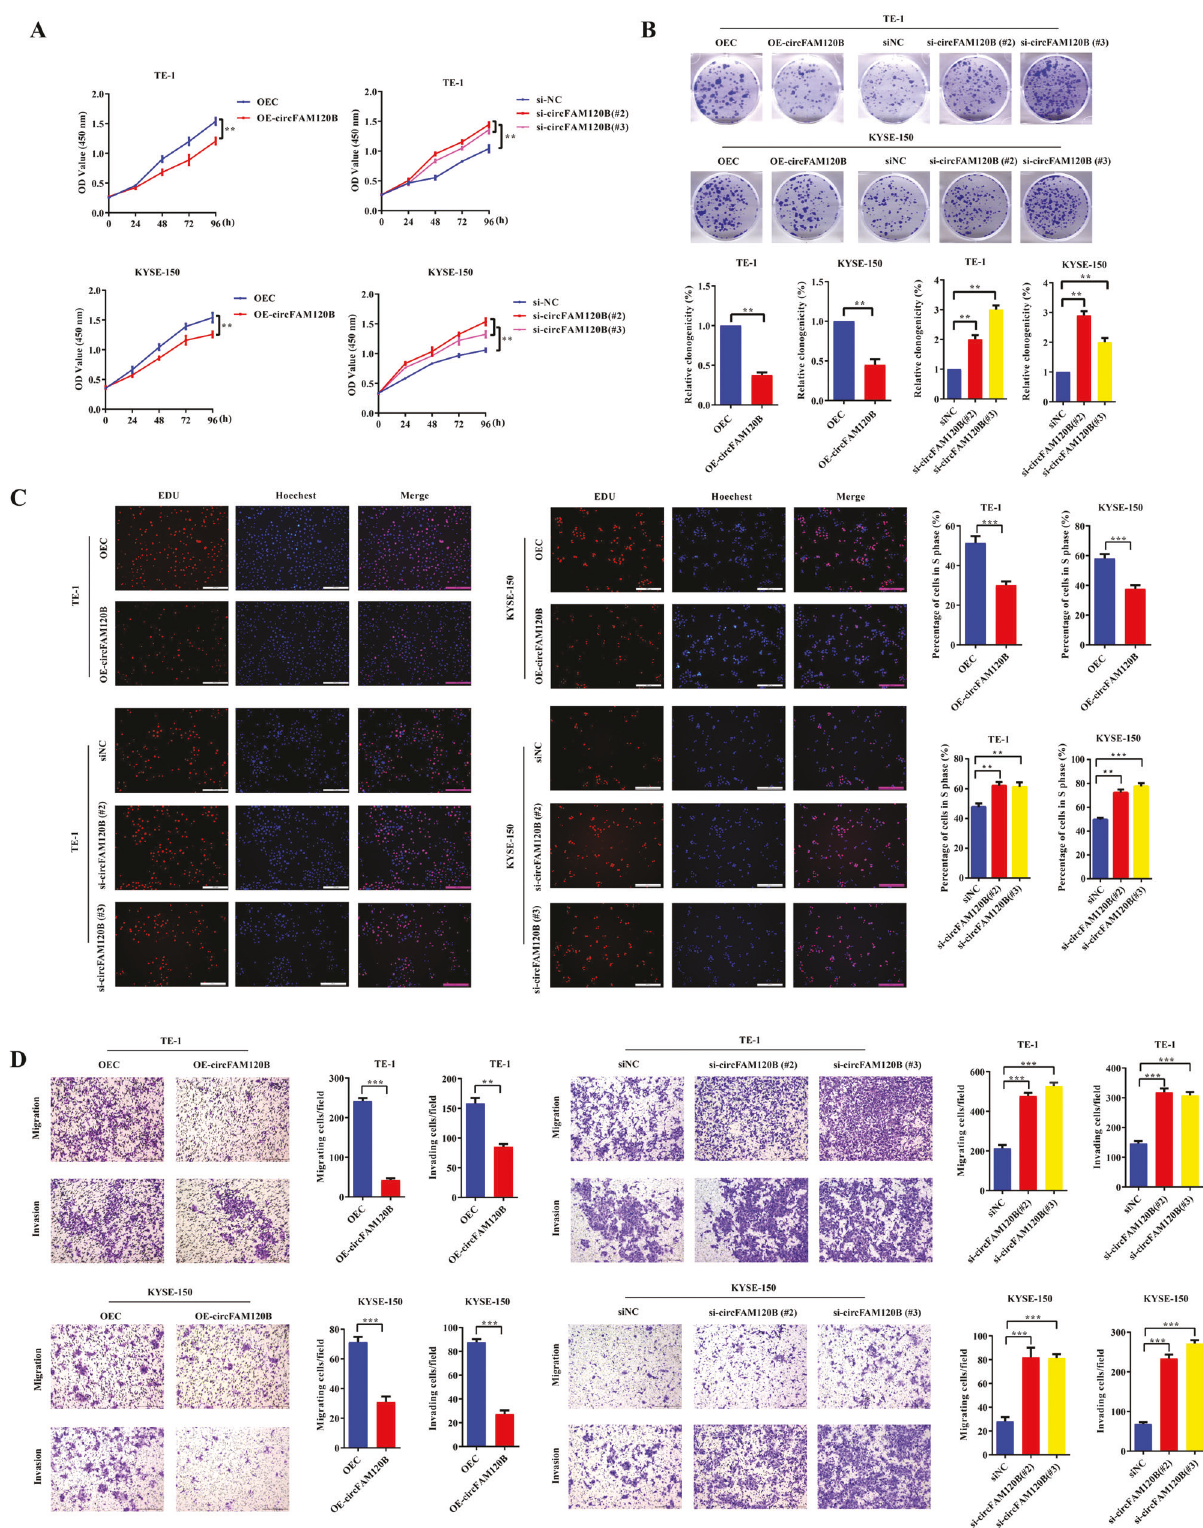
Fig. 2 circFAM120B acts as a tumor suppressor in ESCC cells. A Proliferation of ESCC cells with circFAM120B overexpression or knockdown was evaluated by CCK-8 assay ( n = 5 biologically independent replicates). B Colony formation assays were performed in ESCC cells with circFAM120B overexpression or knockdown ( n = 3 biologically independent replicates). C Detection of proliferating ESCC cells with circFAM120B overexpression or knockdown by EdU assay ( n = 3 biologically independent replicates). D Migration and invasion of ESCC cells with circFAM120B overexpression or knockdown were assessed by Transwell assays ( n = 3 biologically independent replicates). ** P < 0.01, *** P < 0.001.